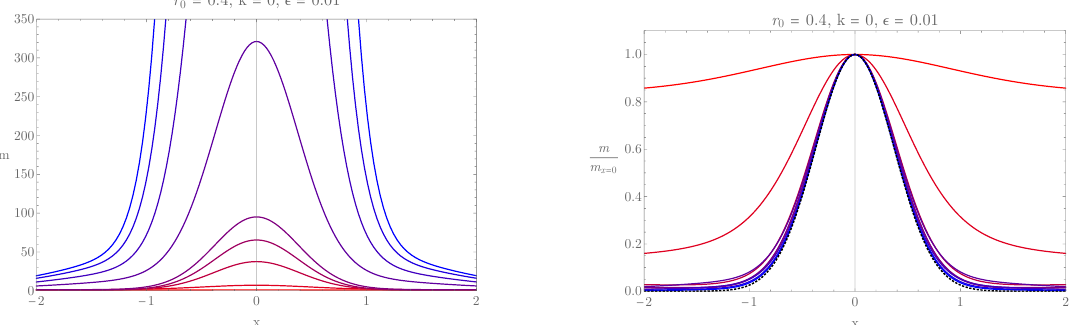
Figure 2 . Scenario 1. Left: indefinite growth of a tsunami, with each higher curve a time t ∼ 3 . 33 later than the previous one. Right: same as left, but with mass function rescaled by its value at x = 0 , showing approach to the gaussian blob (dashed line). This is interpreted as evolution to a very fat